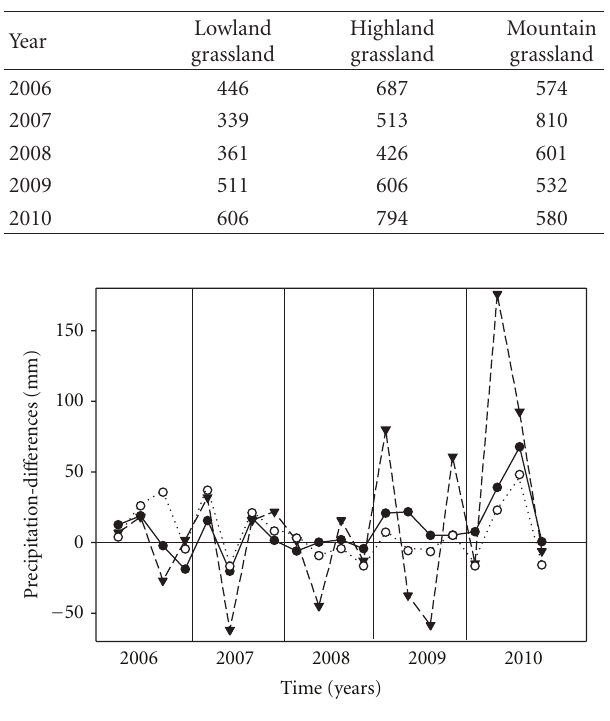
Table 2: Amount of precipitation (the full natural rainfall: ambient treatment in mm per growing season) recorded at the studied sites (Lowland: Havran´ıky, Highland: Kameniˇcky; Mountain: B´ıl´y Kˇr´ıˇz)